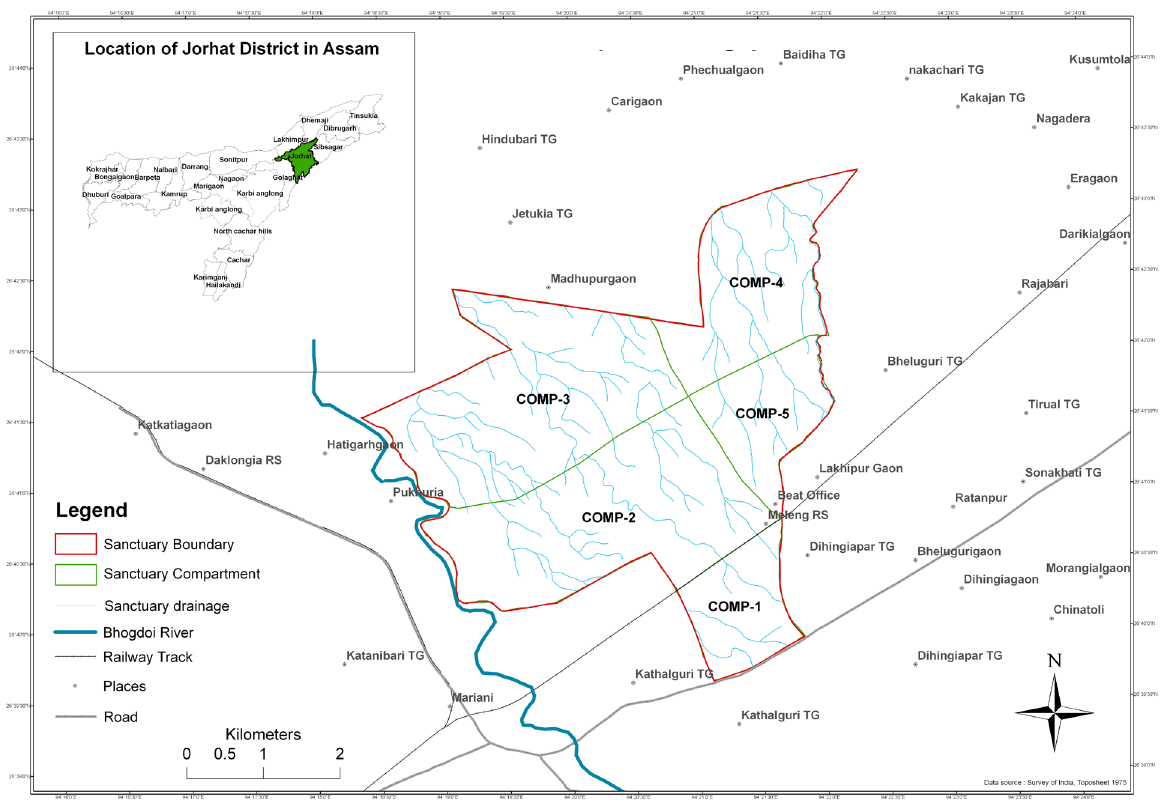
Figure 1. Location map of Hollongapar Gibbon Wildlife Sanctuary - study